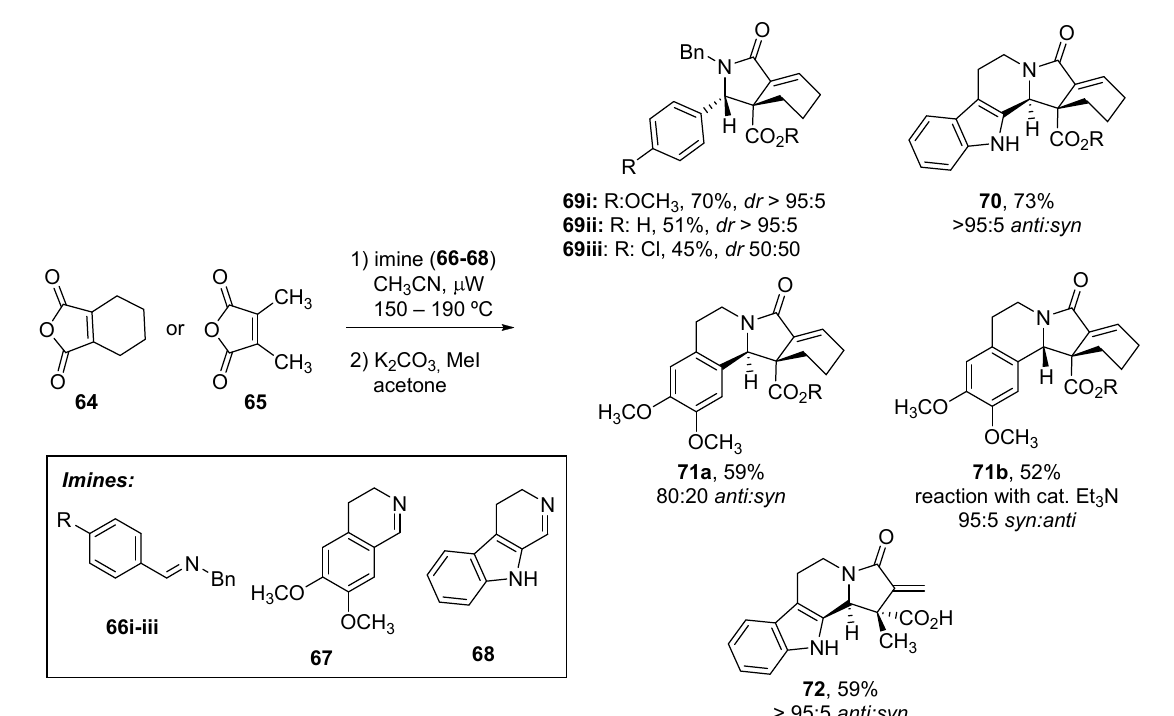
Scheme 24. CCR with alkyl-substituted maleic anhydrides.